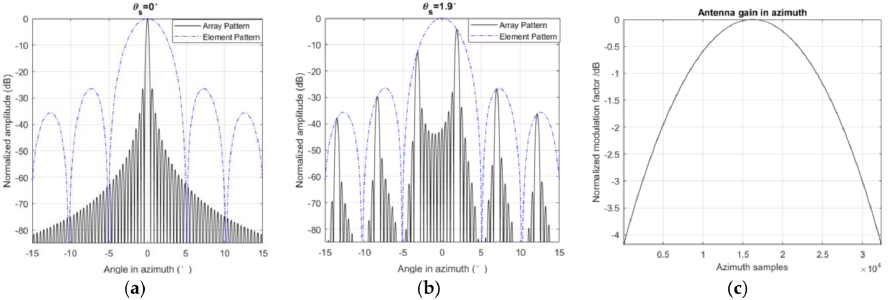
Figure 3. Antenna pattern of GF-3. ( a ) The antenna pattern when θ s = 0 ◦ ; ( b ) The antenna pattern when θ s = 1.9 ◦ ; ( c ) The normalized modulation factor of GF-3 antenna gain in azimuth in this experiment.